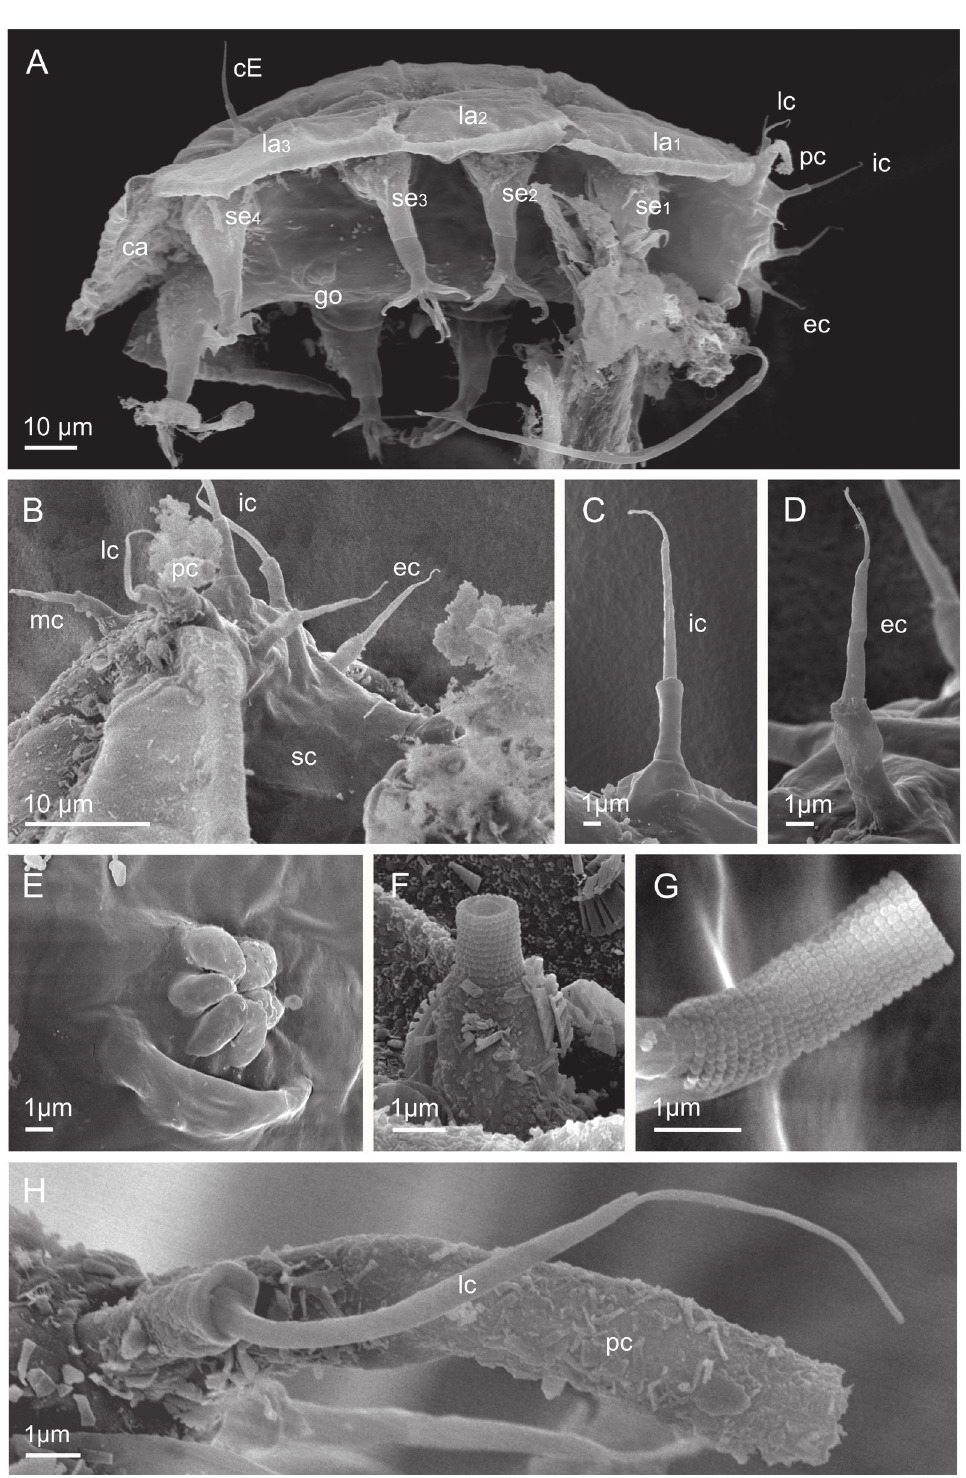
Fig. 4. SEM-micrographs of Higginsarctus signeae gen. et sp. nov., paratype, ♀ (NHMD-293902). A . Ventro-lateral overview. B . Close up on the head, lateral view showing cephalic cirri and secondary clava. C . Internal cirrus. D . External cirrus. E . Gonopore and genital stoup. F–G . Scapus of cirrus E broken in two (note the unique small papillae of scapus). H . Primary clavae (broken) and lateral cirrus. Abbreviations: see Material and